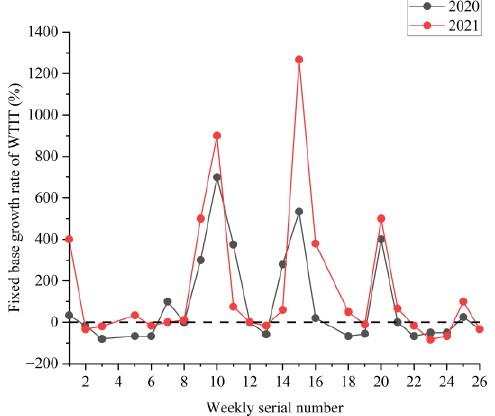
Figure 6. Fixed base growth rate of WTIT.